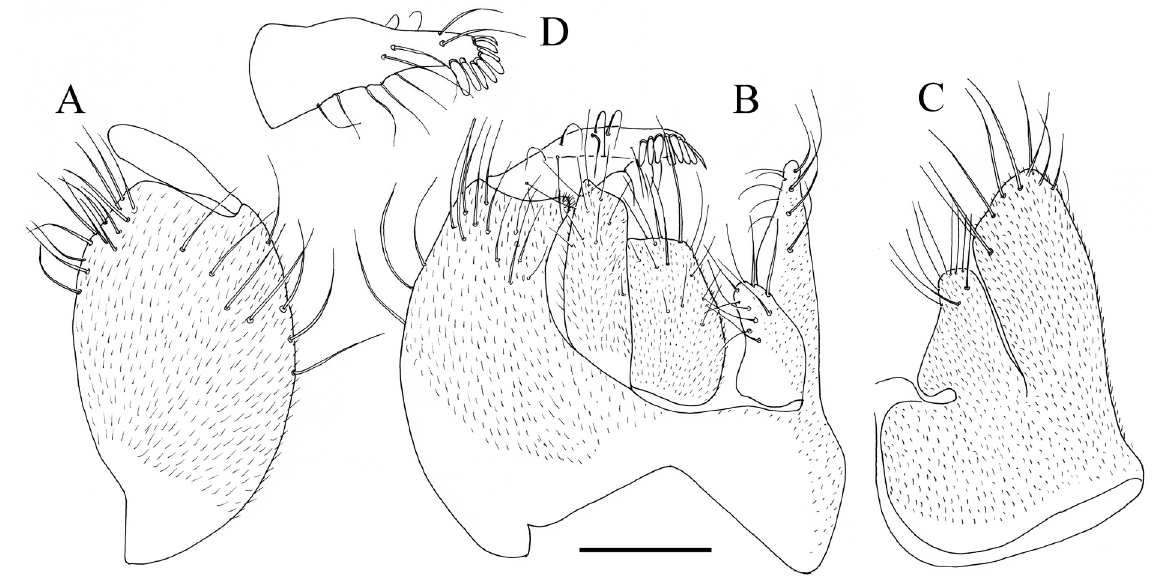
Fig. 12. Terminalia of Tachydromia pieltaini (Gil Collado, 1936) from Spain, Asturias, Covadonga (RBINS). A . Right surstylus and right epandrial lamella. B . Epandrium with cerci. C . Left epandrial lamella and left surstylus. D . Right surstylus. Scale bar: 0.1